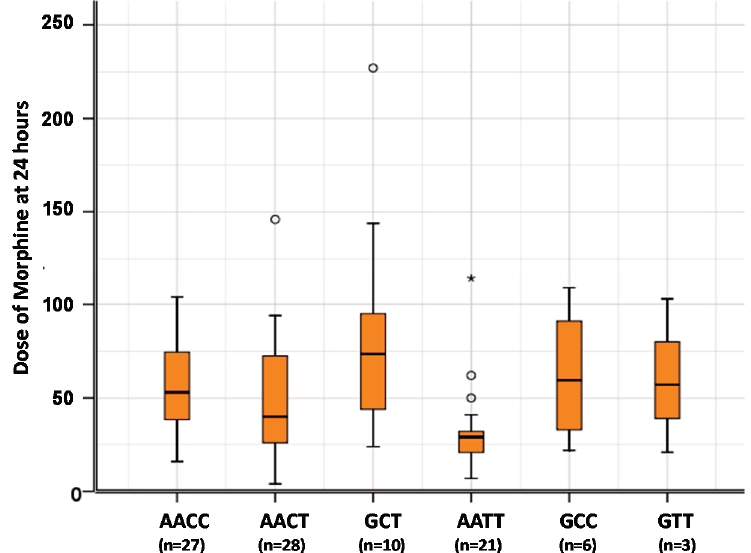
Figure 1. Doses of morphine at 24 h based on genotype distribution for both OPRM1 and ABCB1 SNPs. Morphine dose requirements according to the genotypes for the two SNPs OPRM1 c.118A>G and ABCB1 c.3435C>T. Due to the small number of 118GG patients, the results are grouped by G allele (the patients carrying at least one G allele). o Outliers or doses values that extend more than 1.5 box-lengths from the edge of the box; * Extreme values or doses values that extend 3 box-lengths from the edge of the